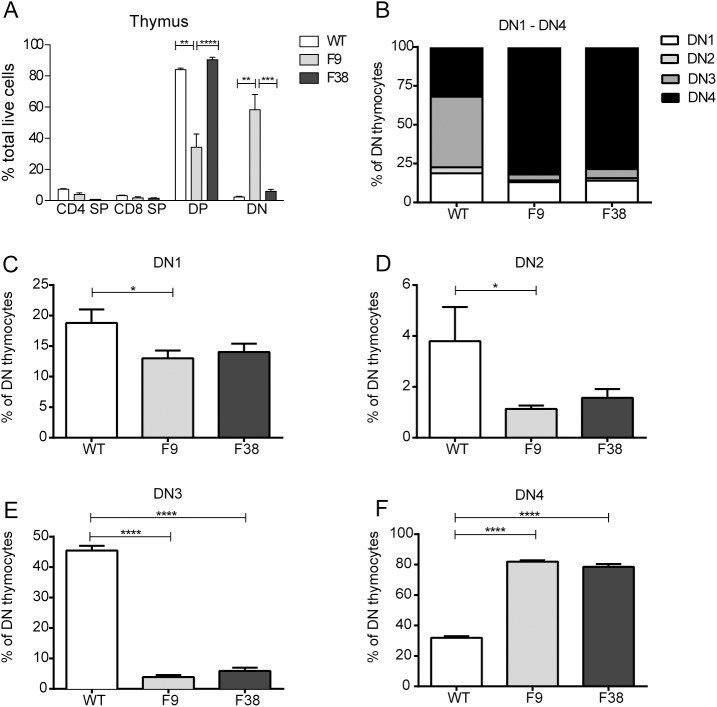
Thymic development is altered in vav-CAR mice.The thymus from vav-CAR and WT mice were harvested and dissociated into single cell suspensions. Cells were incubated in Fc receptor block for 10 minutes prior to staining for flow cytometry. 5x105 cells were stained with the following surface markers; TCRβ, CD3, CD4, CD8, CD25 and CD44. Data represents the mean ± SEM of A; WT = 4, F9 and F38 = 4–8, B-F WT = 4, F9 and F38 = 8 mice. *p<0.04, **p<0.004, ***p<0.0009, ****p<0.0001. SP: Single positive for CD4 or CD8, DP: Double positive for both CD4 and CD8, DN: Double negative for both CD4 and CD8, DN1: CD44+CD25-, DN2: CD44+CD25+, DN3: CD44-CD25+, DN4: CD44-CD25-.